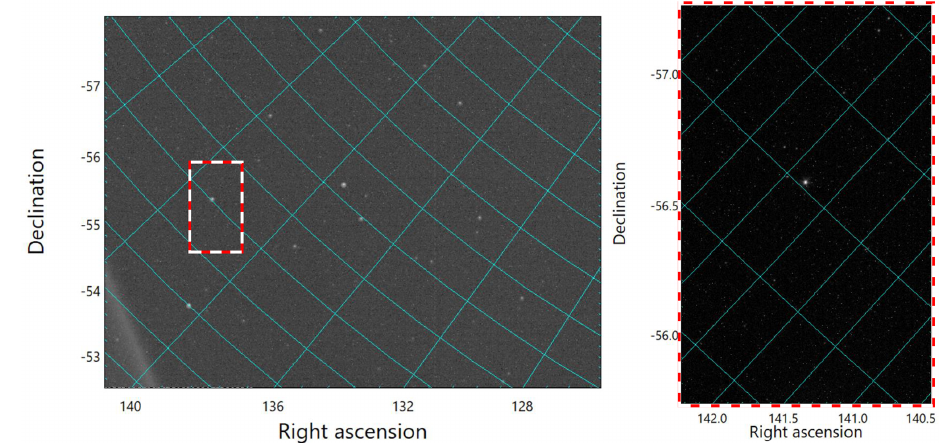
Figure 2. A star field imaged by both the star tracker and GEOStare SV2. The ST image shows the GS2 field of view approximately drawn as a dashed red and white